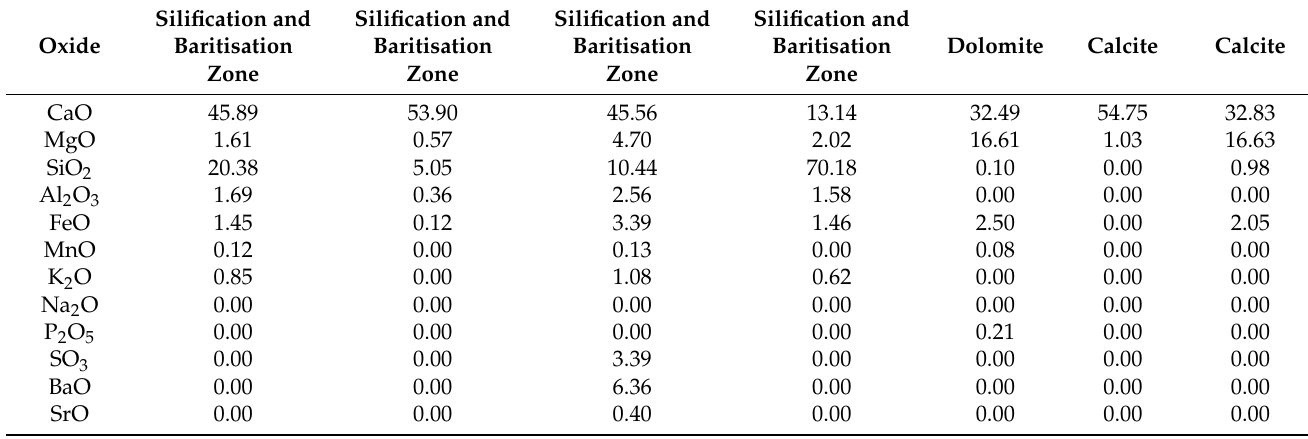
Table 5. Chemical composition of minerals of organogenic dolomitic limestone samples taken from the surface of a rock outcrop, wt. %.